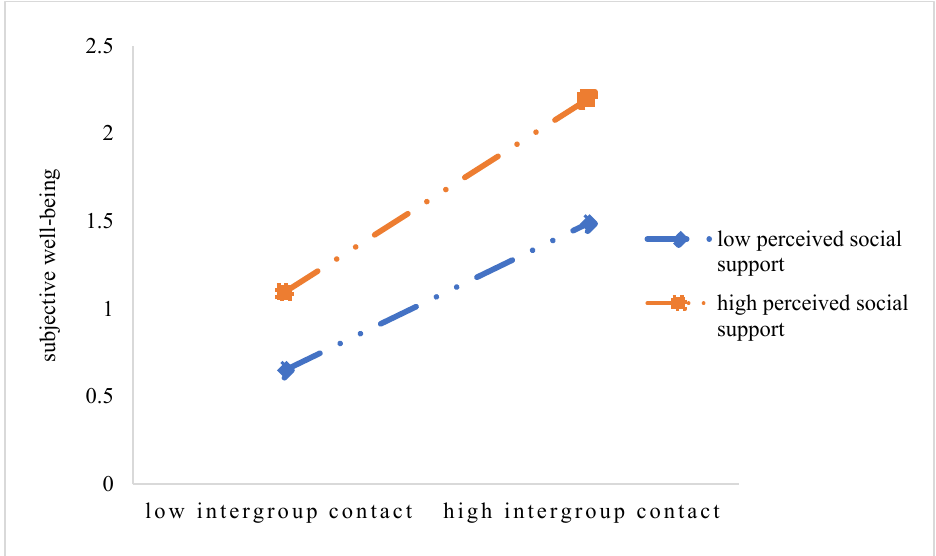
Figure 3. The interaction effects of global intergroup contact and social support on subjective well- being.